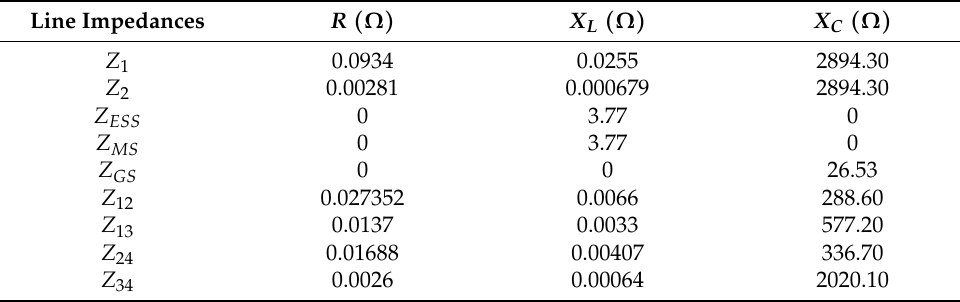
Table A1. Microgrid testbed impedances